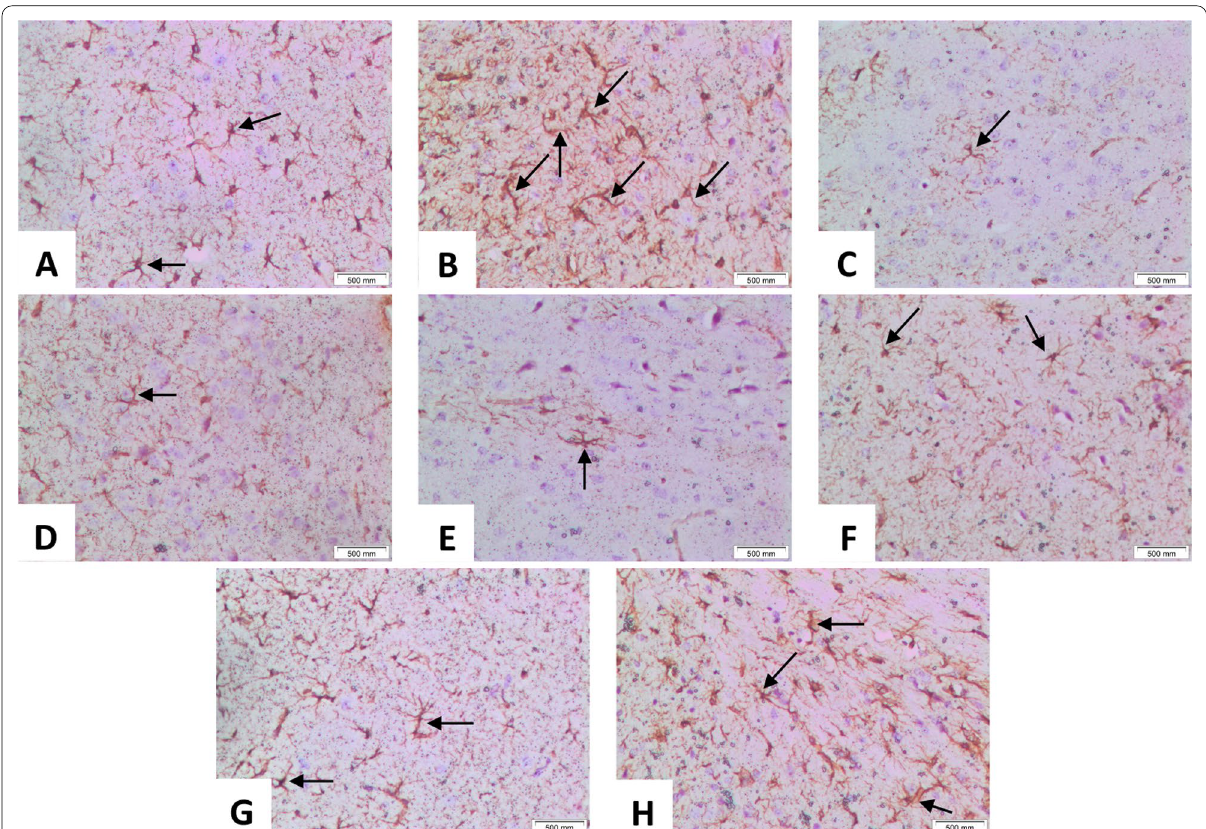
Fig. 11 Effect of each of l -dopa and rasagiline (R) alone or in combination with caffeine (CAF) or coffee (COF) on GFAP immunohistochemically stained brain tissue sections in paraquat (PQ)-treated mice. A Normal mice showing normal small GFAP ve astrocytes (arrows), with surrounding + normal neurons. B PQ-treated mice showing astrogliosis with numerous large deeply stained GFAP ve astrocytes with numerous branching + processes (arrows). C l -dopa CAF PQ-treated mice showing marked reduction of GFAP ve astrocytes (arrow). D – F Mice treated with + + + l -dopa + COF + PQ, l -dopa + PQ and R + CAF + PQ showing reduction in GFAP + ve astrocytes (arrows). G , H R + COF + PQ and R + PQ-treated mice showing several GFAP ve astrocytes (arrows) (IHC + ×